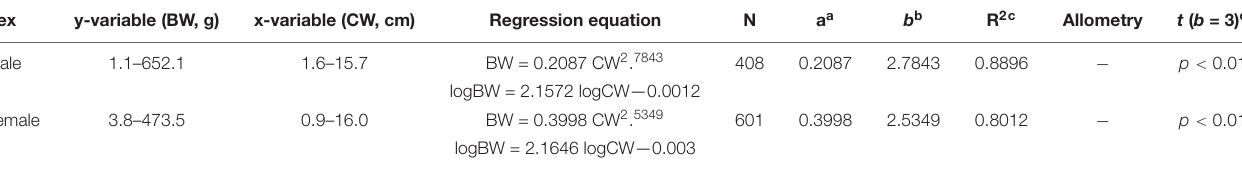
TABLE 2 | Regression equations and estimated parameters of length–weight relationships for Calappa philargius by sex sampled in the southern Taiwan Strait, China. Sex y-variable (BW, g) x-variable (CW, cm)